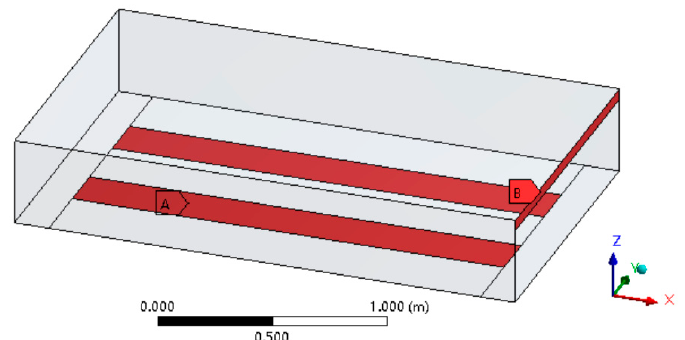
Figure 3. Details of the tank model (A is the water-dump valve, and B is the ventilation opening, for the dimensions of the tank and valve, see the description given in the main